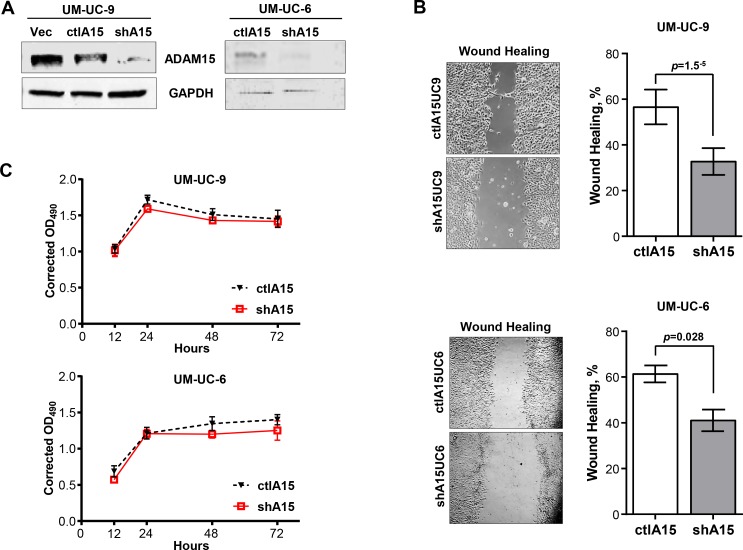
Knockdown of ADAM15 inhibits bladder tumor cell motility.A) ADAM15 immunoblot of UM-UC-9 bladder cancer cells expressing empty vector and scrambled ADAM15 sequences (ctl) and short hairpin RNA (shA15) and UM-UC-6 expressing scrambled ADAM15 sequences (ctl) and short hairpin RNA (shA15). Glyceraldehyde-3-phosphate dehydrogenase (GAPDH) was used as loading control. B) Wound healing assay comparing extent of wound closure in shA15 UM-UC-9 and shA15 UM-UC-6 cells compared to controls (ctl). Bars represent mean ± SD (n = 4) of one of two independent experiments (UM-UC-9, top) and mean ± SEM (N = 3) (UM-UC-6, bottom). C) Proliferation assays of both knockdown (shA15) and control (ctl) UM-UC-9 and UM-UC-6 cells over a 72 hour time course. Results represent mean ± SD of one of three independent experiments.